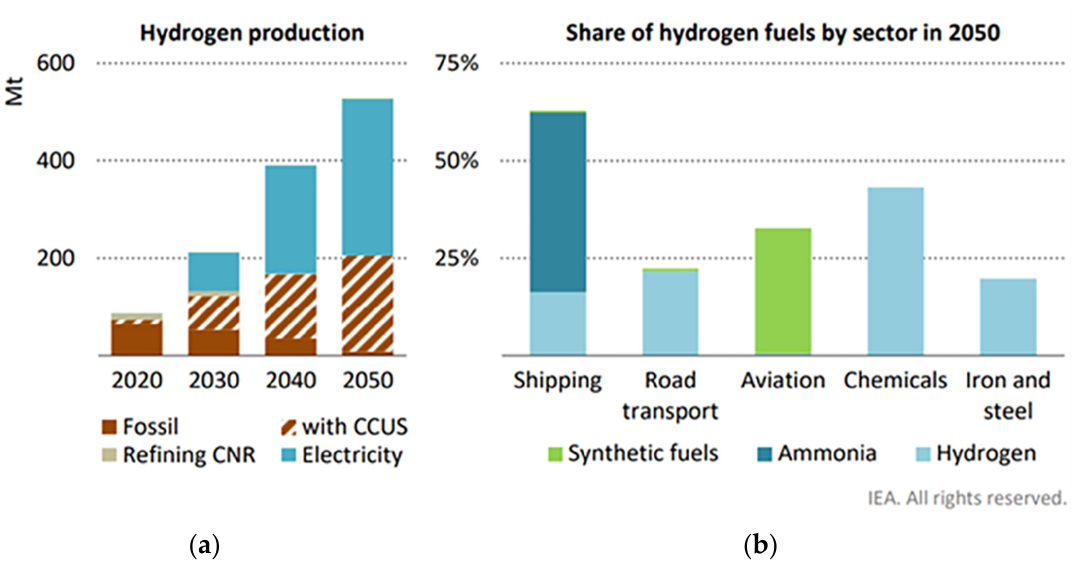
Figure 1. Expected annual demand for hydrogen based on ( a ) hydrogen production technologies and ( b ) sectors (Mt). Hydrogen produced by electrolysis, and also as a by-product of catalytic naphtha reforming (CNR) based on technology of carbon capture, utilization and storage (CCUS). Reprinted with permission [4].